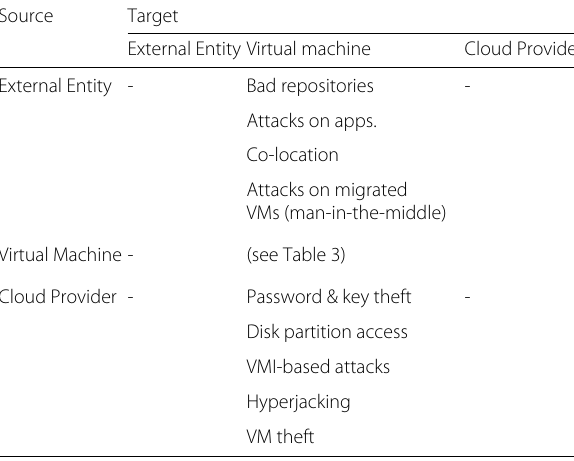
Table 2 Class 2: Attacks targeting